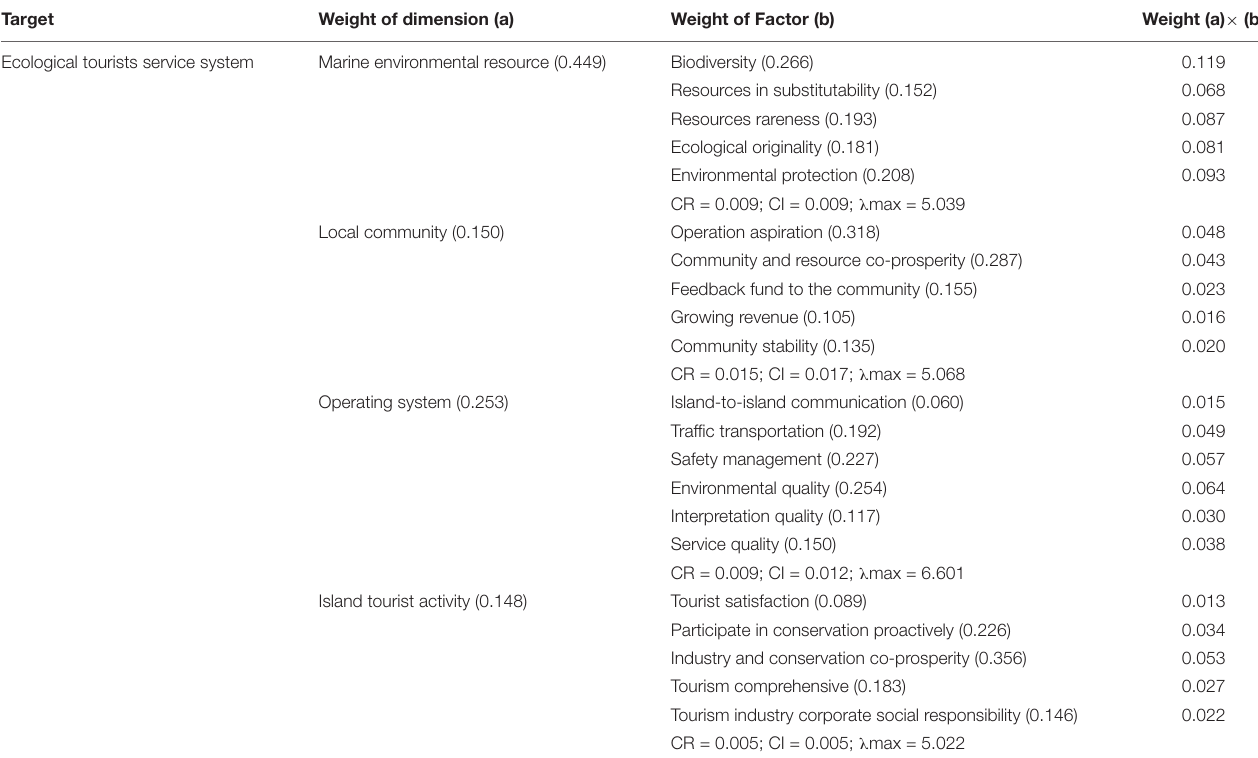
TABLE 9 | The different level weight ratios of the ecosystem service system in the Penghu National Scenic